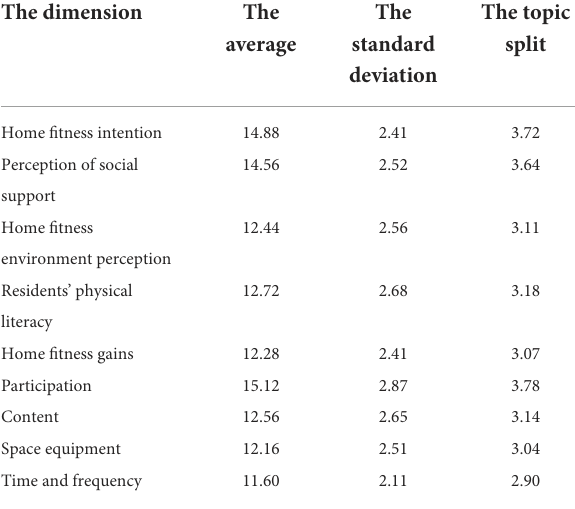
TABLE 7 The average value, standard deviation, and the average score of each dimension. The dimension